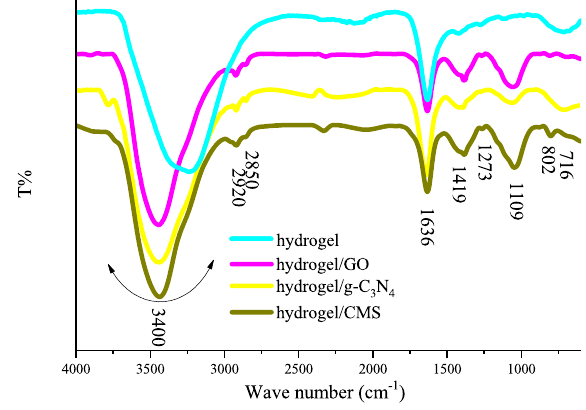
Figure 3. FTIR spectra of the samples.